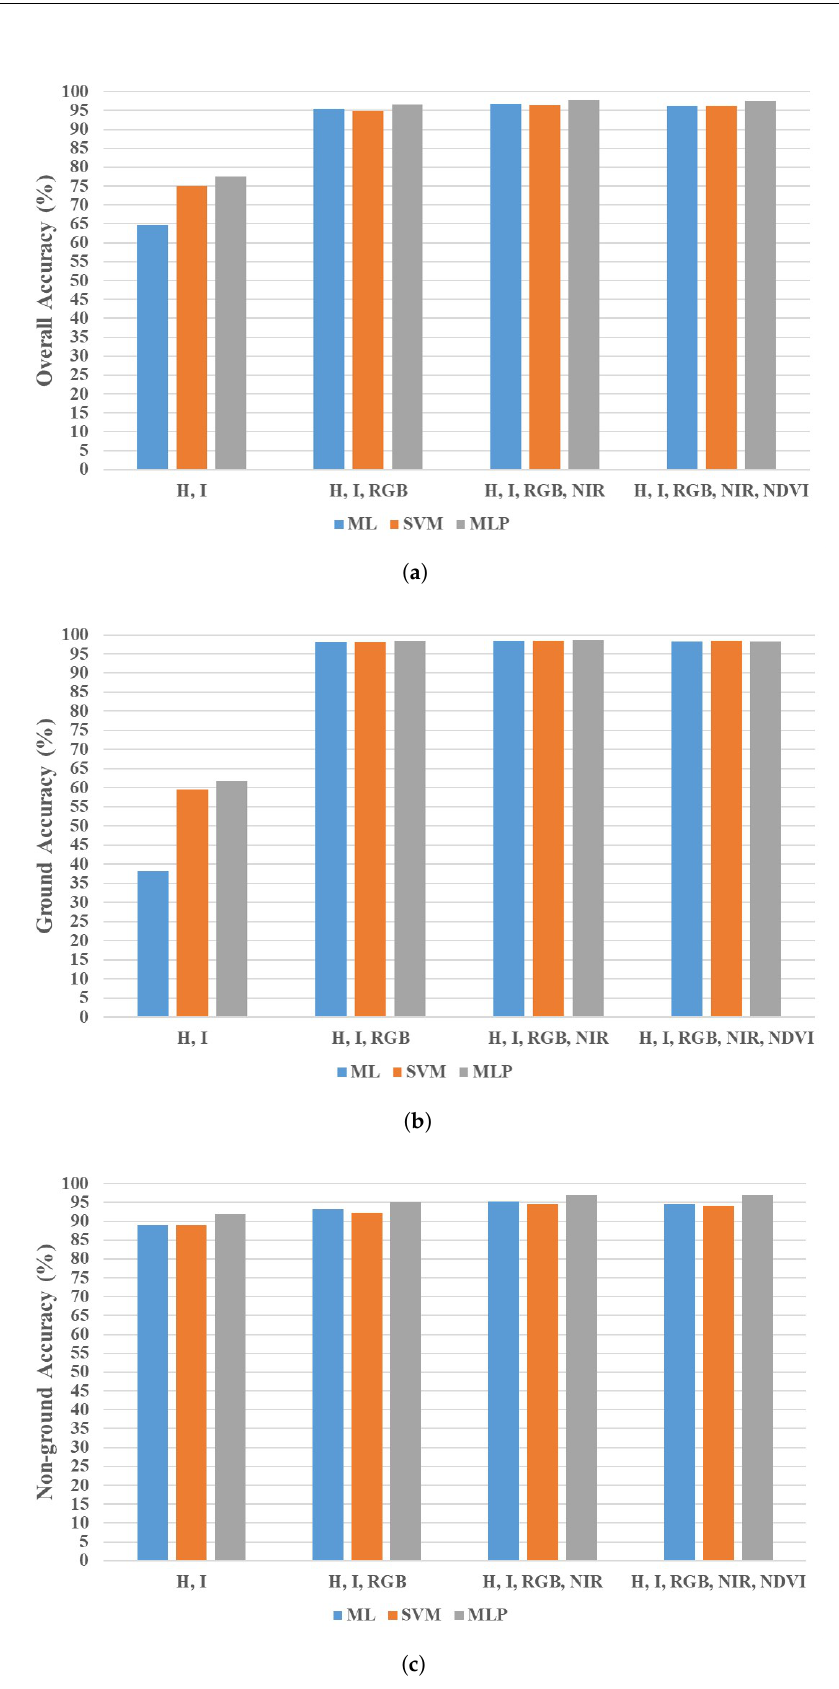
Figure 14. Classification accuracy (test set). ( a ) Overall classification. ( b ) Ground accuracy. ( c ) Non- ground